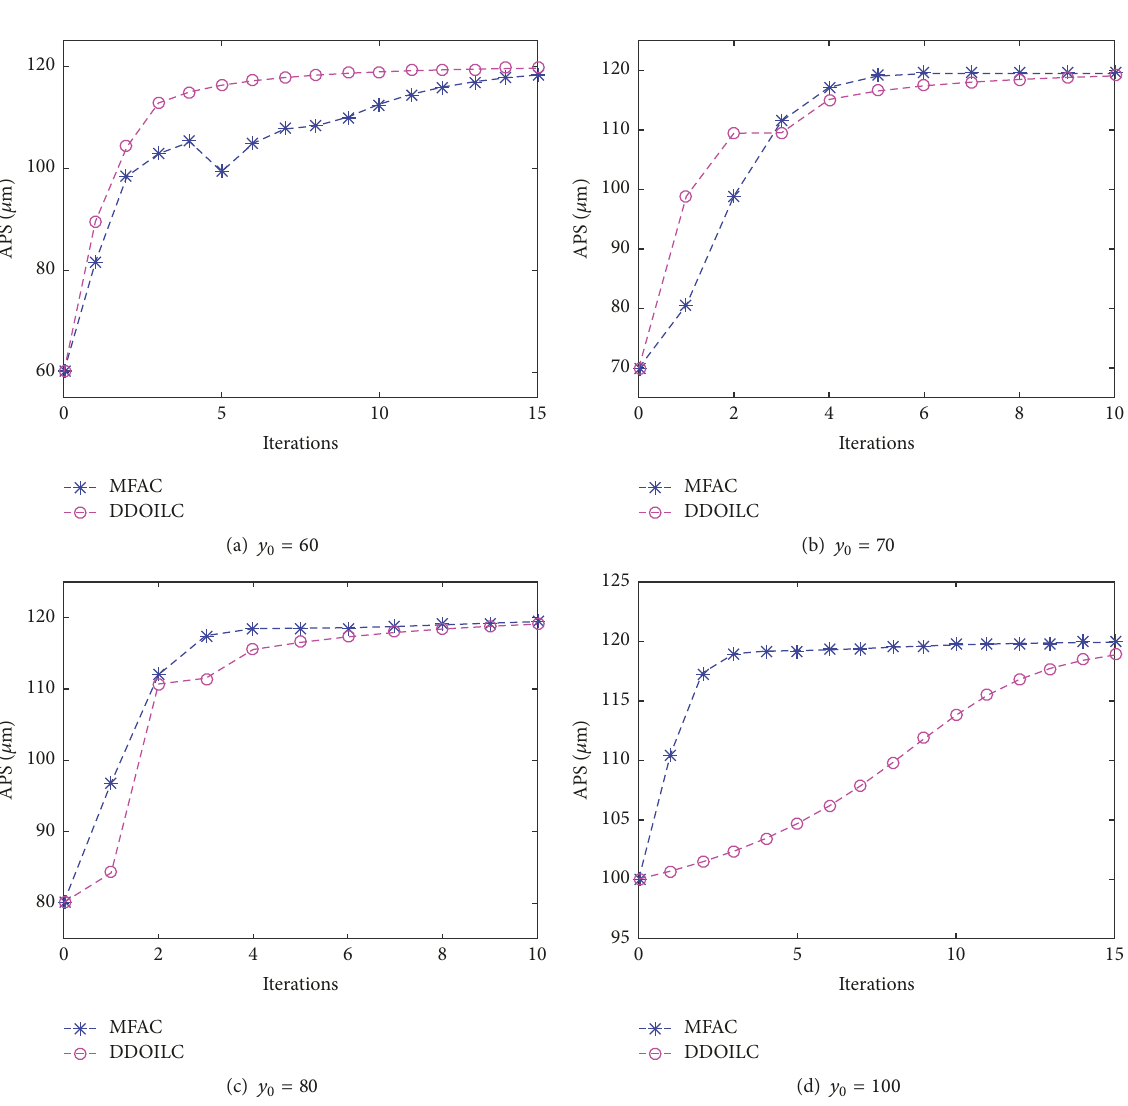
Figure 3: The control profiles of APS in SFBGP based on MFAC and DDOILC.